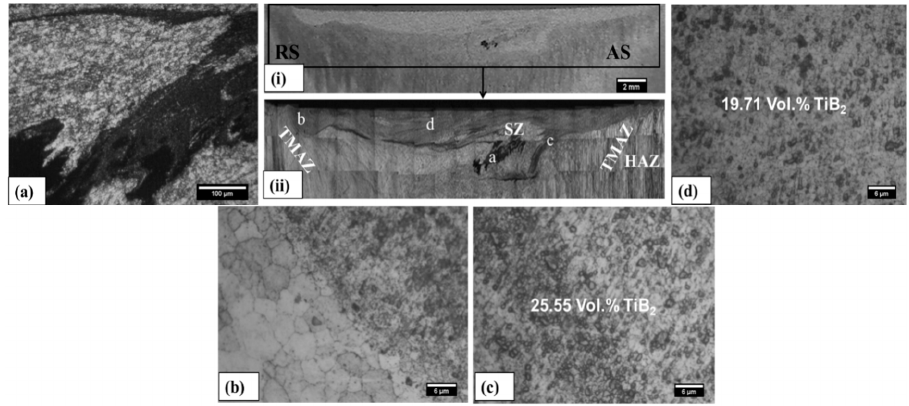
Figure 13. ( i ) Macro-image of cross-section of Sample 7. ( ii ) Microstructure of cross-section of the rectangle in macro-image showing: ( a ) agglomerated region; ( b ) RS reinforced zone interface; ( c ) mixed region; and ( d ) dispersed region.